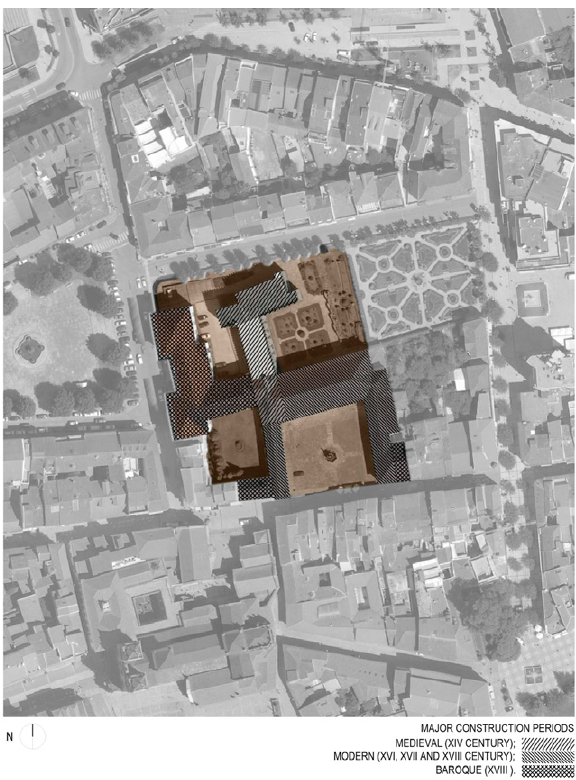
Figure 3. Archbishop’s Palace chronology Figure 4. Allocation of